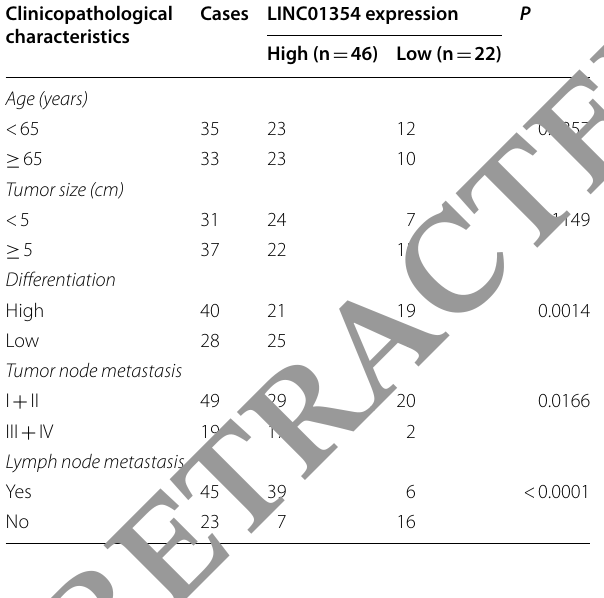
Table 2 Correlation between the expression of LINC01354 and clinicopathological characteristics of EC Clinicopathological